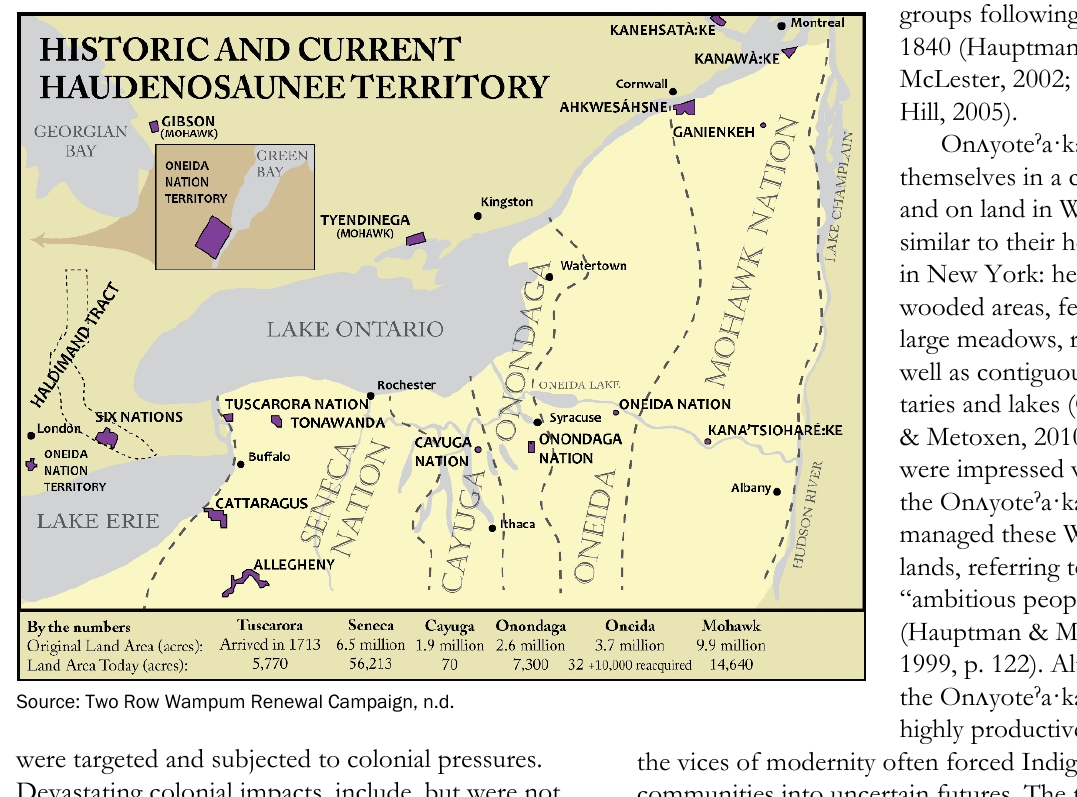
Figure 1. Historic and Current Haudenosaunee Territory